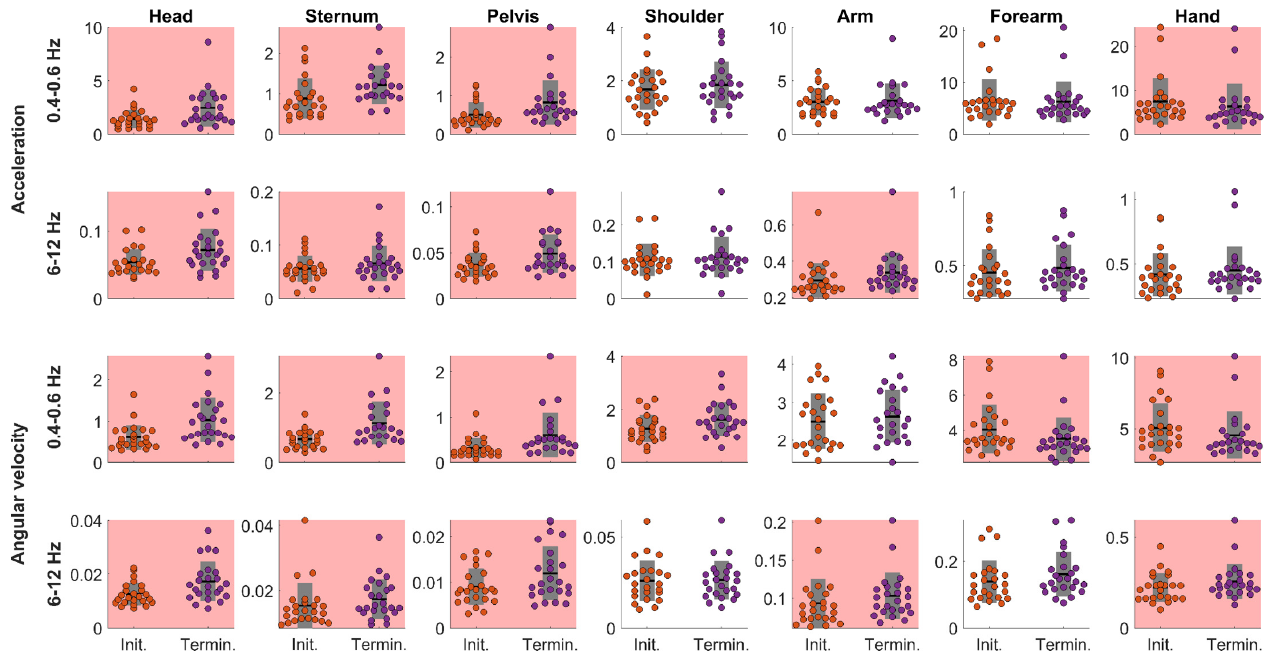
Figure 3. RPT Initiation versus Termination power spectrum for the acceleration and angular velocity in the 0.4-0.6 Hz and 6-12 Hz frequency bands for the head, sternum, pelvis, shoulder, arm, forearm, and hand. Dots represent each participants’ data. Black horizontal lines represent the participants means; grey bars represent standard deviations. Pink backgrounds indicate significant differences between task Initiation and Termination . Table 1. T and p values and Cohen’s d effect sizes for each comparison performed between Task Initiation and Termination and pre- and post-RPT work